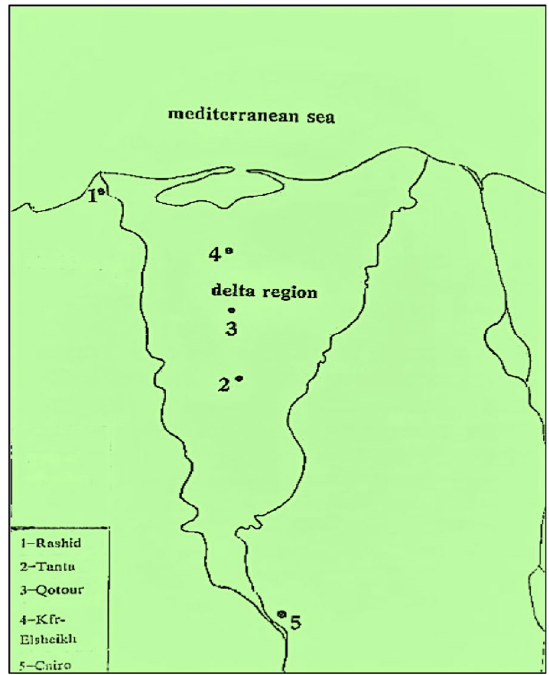
Fig. 1 Map of the Nile Delta in Egypt including study area (Qotour